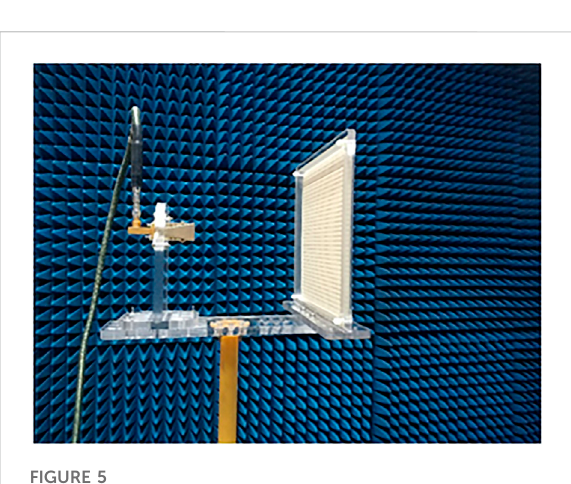
FIGURE 5 The experimental setup and the measurement